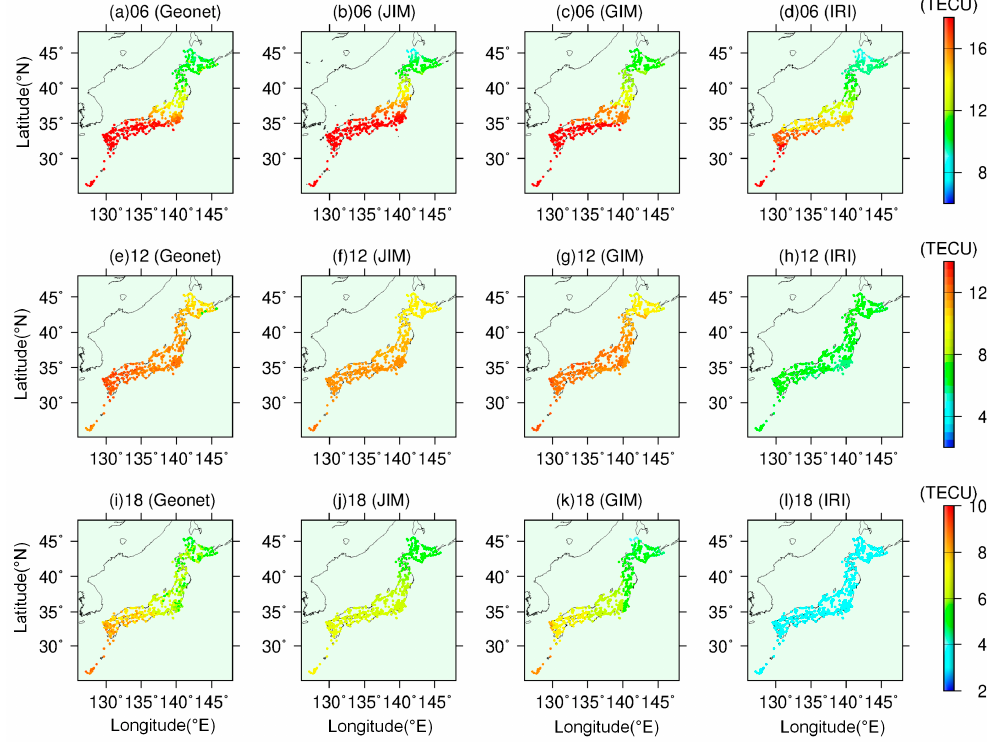
Figure 7. TEC maps derived from the GEONET observations. JIM, GIM and IRI-2016 model at UT06, UT12 and UT18 on 22 March 2021. UT12 and UT18 on 22 March